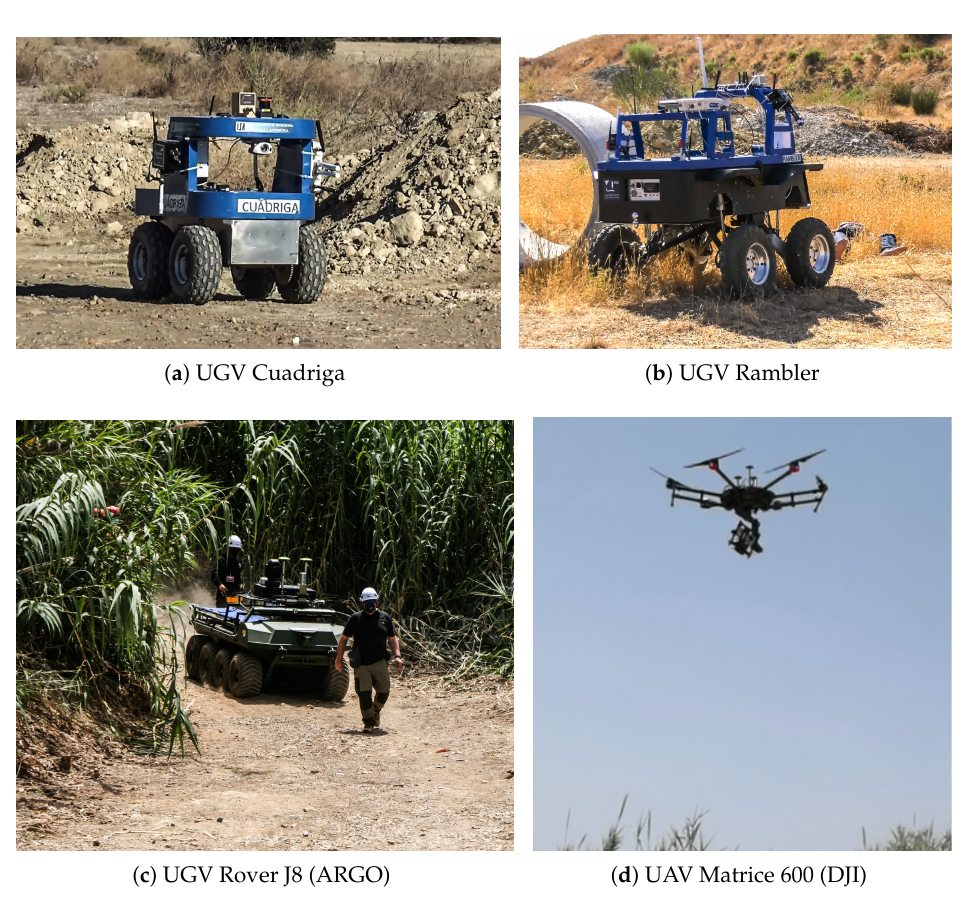
Figure 9. Cooperative